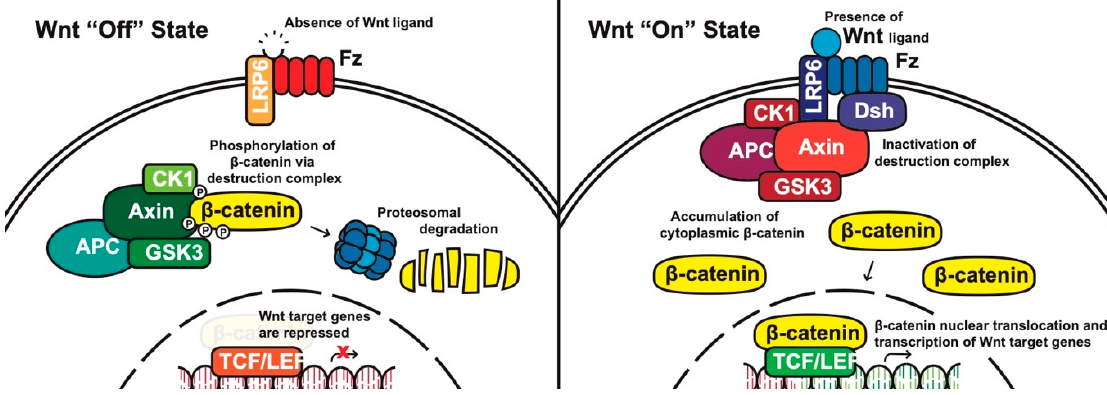
Figure 1. The canonical WNT pathway in on and off states. APC, adenomatous polyposis coli; CK1, casein kinase 1; GSK3, glycogen synthase kinase 3; TCF/LEF, T-cell factor/lymphoid enhancing factor; LRP6, lipoprotein receptor related protein 6; FZD/Fz, Frizzled; Dsh, Disheveled.